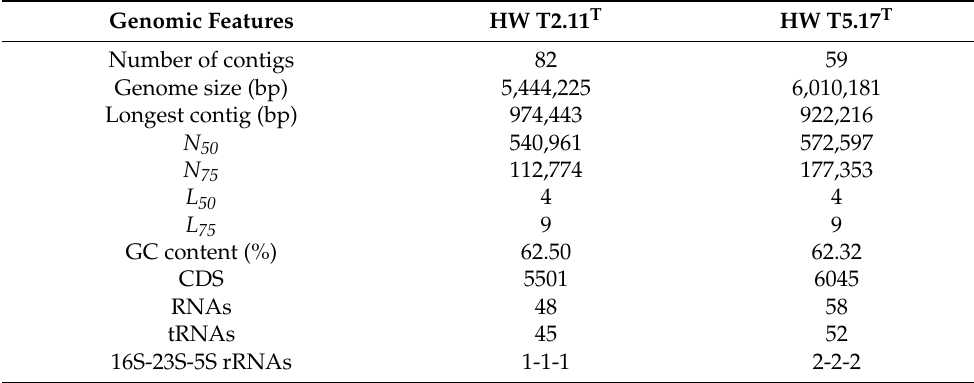
Table 3. Genomic features of strains HW T2.11 T 11 T ( Acidisoma silvae ) and HW T5.17 T ( A. cellulosilytica